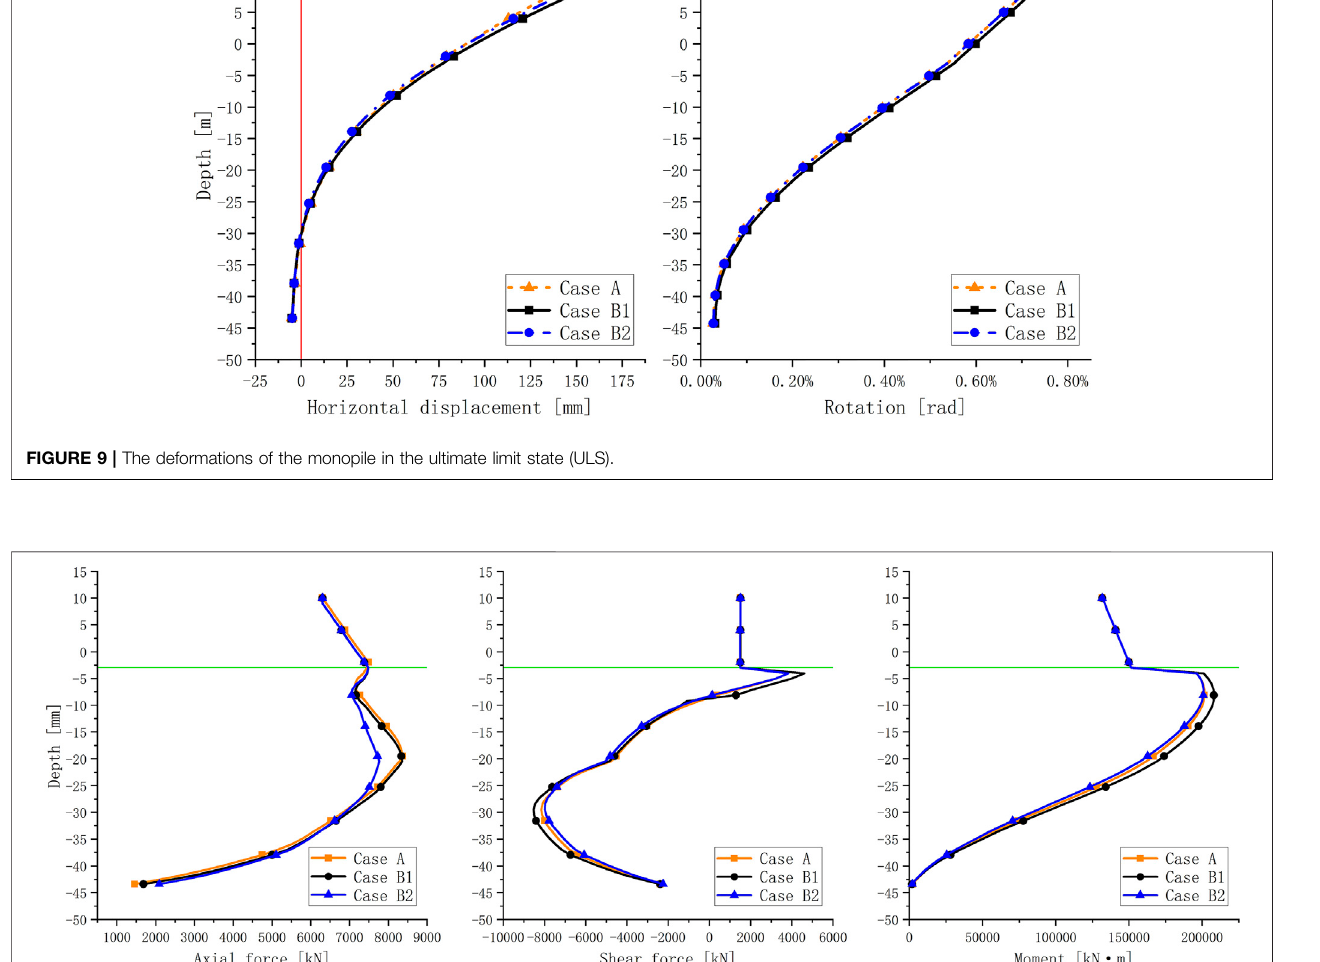
FIGURE 10 | The pro fi le of the internal axial force, shear force, and moment in ULS.